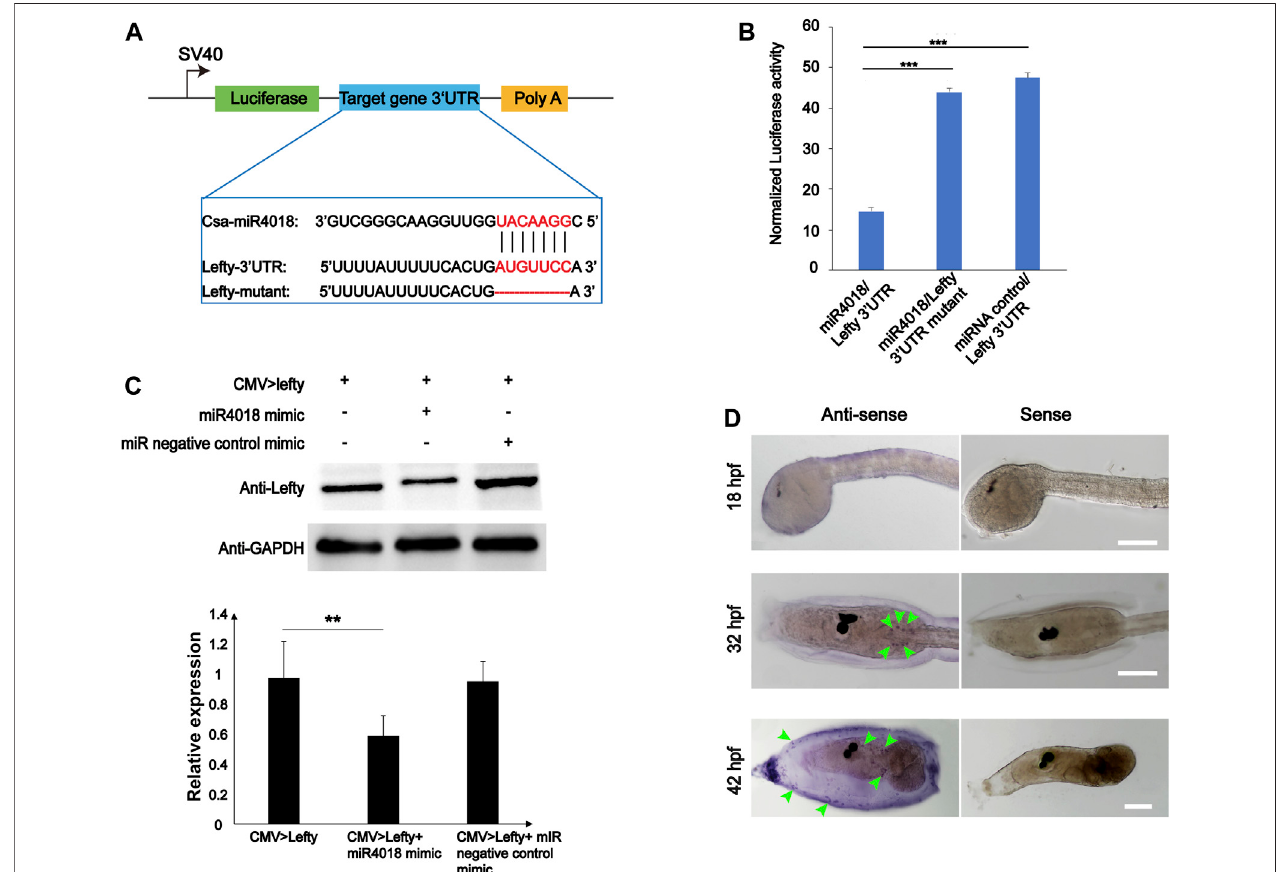
FIGURE3| Lefty isthetargetgeneof miR4018 . (A) Schematicrepresentationofluciferasereporterconstructscarryingthe3 ′ -UTRregionsoftargetgenes. Lefty -3 ′ UTR, Lefty -3 ′ UTR mutants were cloned into the downstream luciferase open reading frame of the pmirGLO dual-luciferase vector. Sequence alignments of csa - miR - 4018 and its predicted target gene and Lefty -3 ′ UTR and mutants are displayed in the blue line box. (B) Relative luciferase activity in HEK-293T cells cotransfected with pmirGLO- Lefty 3 ′ UTR and miR4018 mimics, pmirGLO- Lefty 3 ′ UTR mutants and miR4018 mimics , Lefty -3 ′ UTR mutants and miRNA negative control mimics, respectively. Fire fl y luciferase values were normalized Renilla luciferase activity. Student ’ s t-test was used to evaluate the signi fi cance of luciferase data. Asterisks (***) represent statistical signi fi cance ( p < 0.001). (C) Lefty expression at theprotein level in human embryonic kidney 293Tcells (HEK293T). GAPDHwasused as aninternal control in the Western blotting experiments. CMV > Lefty , CMV > Lefty and miR4018 mimics , CMV > Lefty and miRNA negative control mimics were cotransfected into HEK-293T cells, respectively. Expression level of Lefty in CMV > Lefty and m iR4018 mimi c group was signi fi cantly decreased compared with that in the additional two groups. Asterisks (**)representstatisticalsigni fi cance ( p < 0.01). (D) Expression patterns of Lefty detected byw hole-mount insitu hybridization. Hybridized signals were speci fi cally detected in a scattered cell population in the trunk in the embryos and larvae at 31 and 42 hpf (green arrowheads). No visible signal was examined in the embryos at 18 hpf. Scale bar: 100 μ